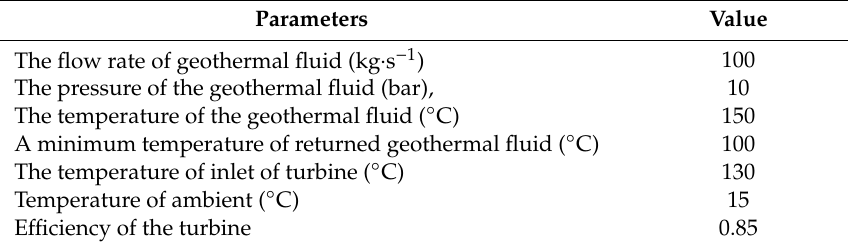
Table 1. The design parameters of present study, Bonyadi et al. [26], Zhou et al. [30], Ba¸so˘gul [31].